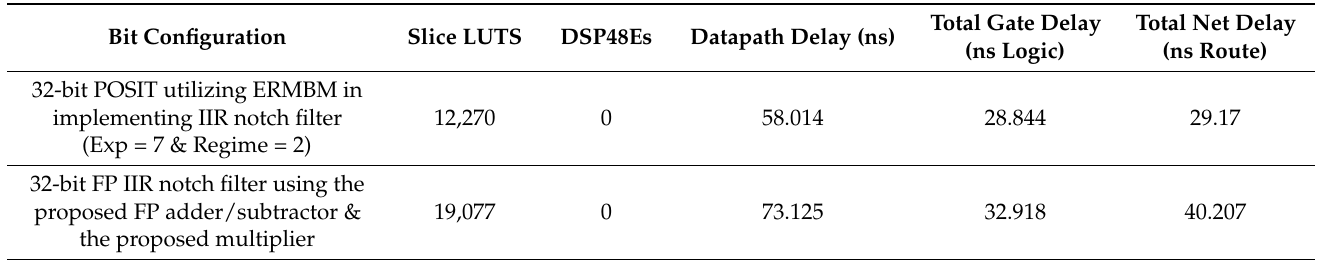
Table 9. Comparison of the area and speed between a 32-bit POSIT IIR notch filter utilizing an ERMBM and a 32-bit floating point second-order IIR notch filter.